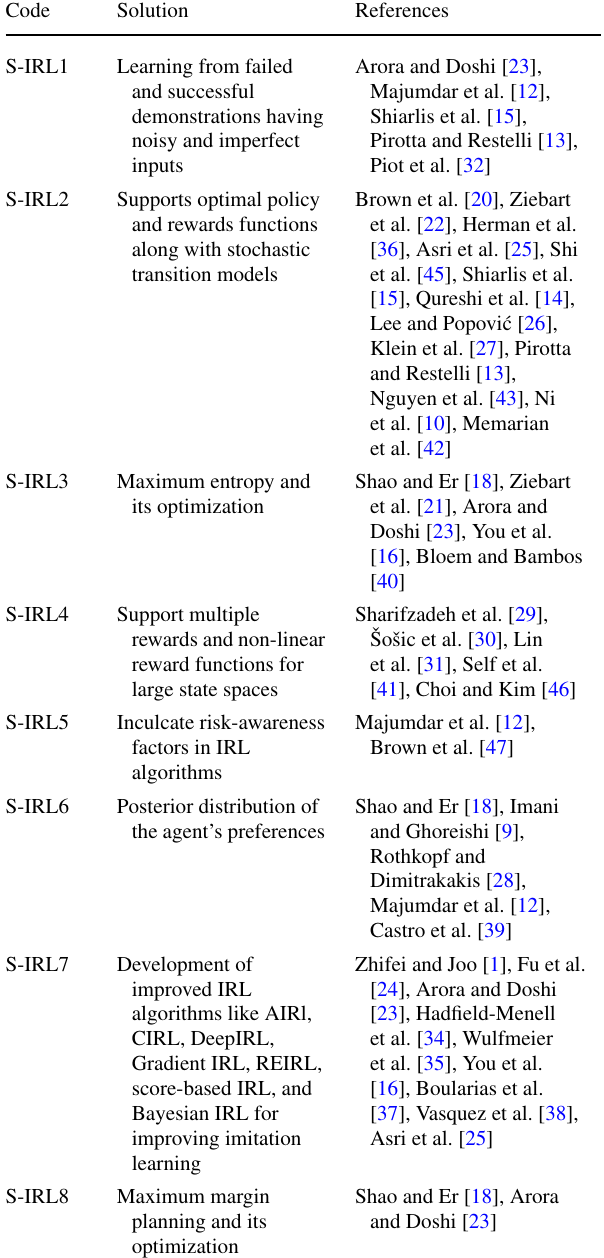
Table 2 Solutions to overcome the problems Code